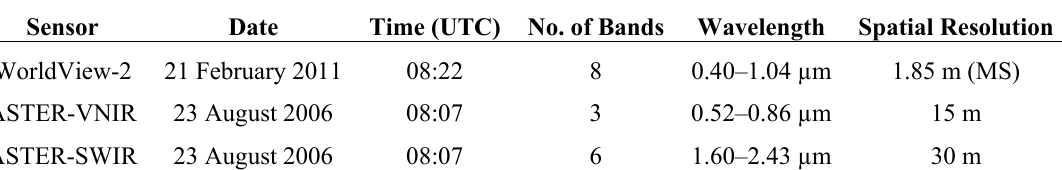
Table 1. Optical remote sensing sensors. MS: multispectral.